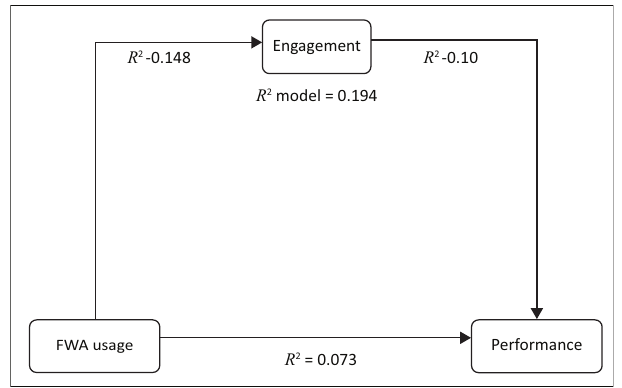
FIGURE 1: Research model.